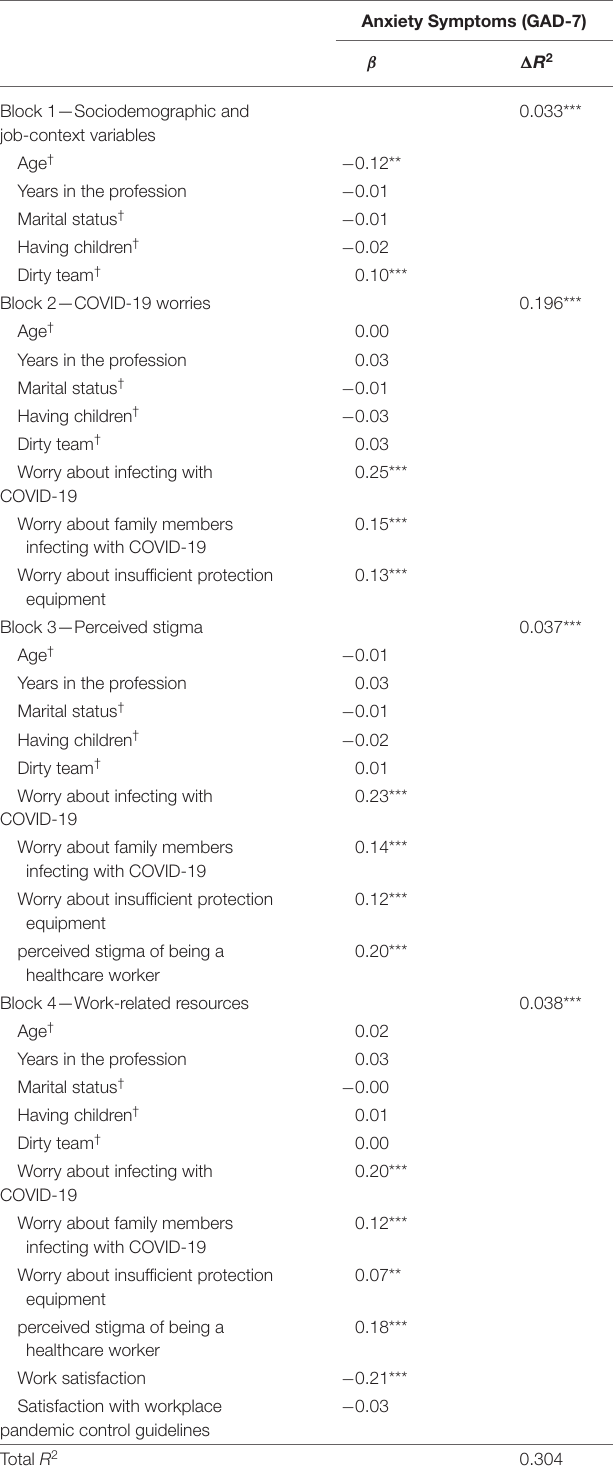
TABLE 3 | Hierarchical regression analyses explaining anxiety symptoms ( N =